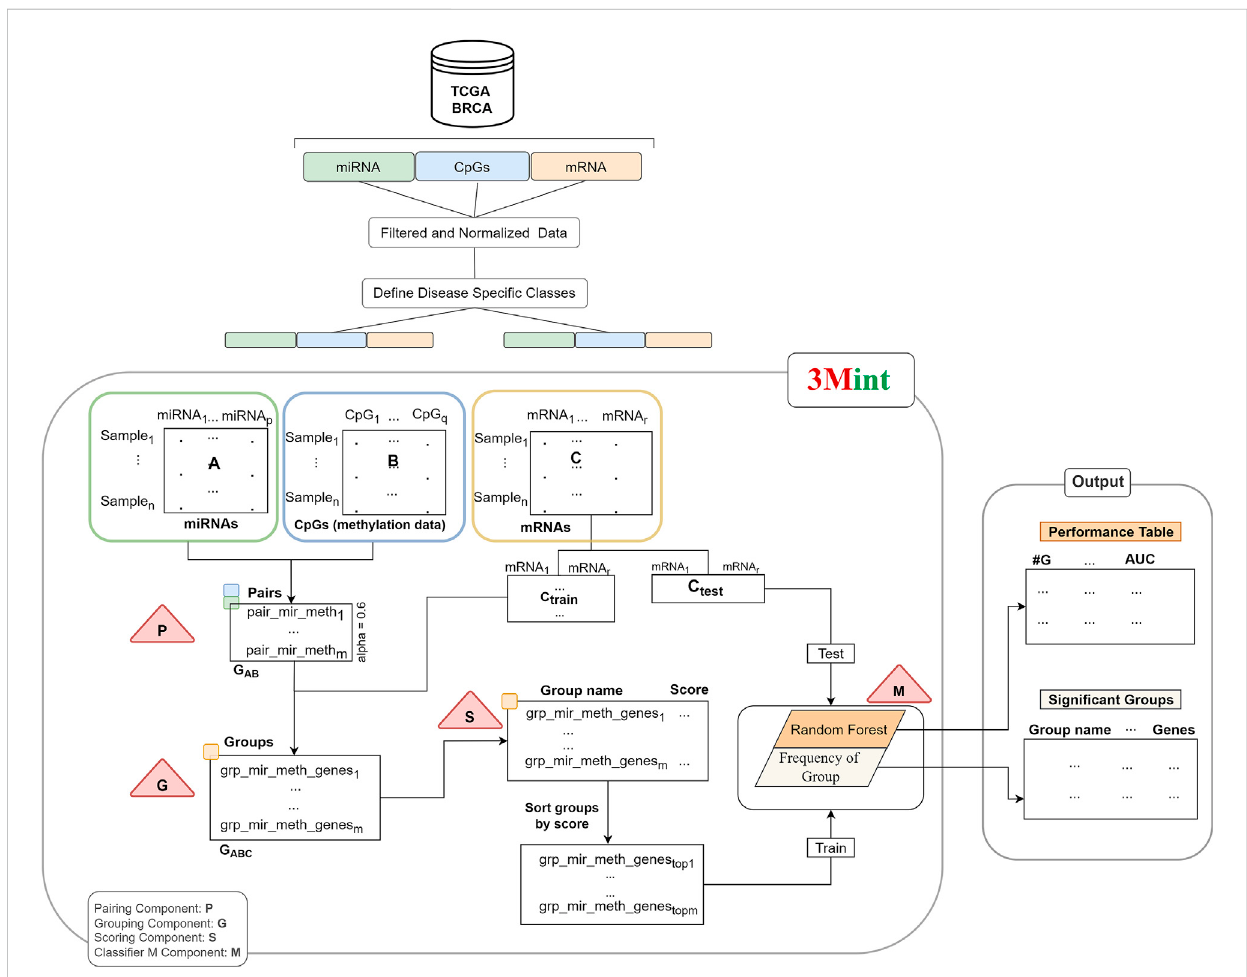
FIGURE 1 The work fl ow of 3Mint. The work fl ow consists of four main components (indicated by triangles), P) detects pairs, G) identi fi es groups, S) scores groups, M) creates the classi fi er model. The output layer consists of the 1) Performance Table, and 2) the Signi fi cant Groups